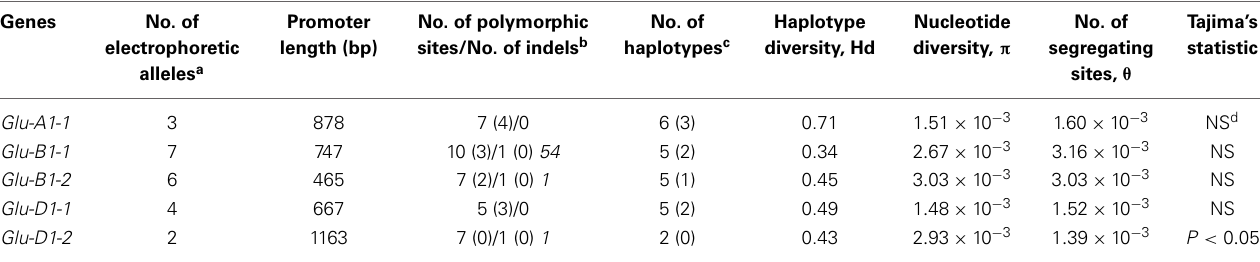
Table 3 | Number of electrophoretic alleles revealed by SDS-PAGE, haplotype and diversity statistics for the promoters of five HMW-GS genes from 42 accessions of the INRA worldwide hexaploid wheat core collection.